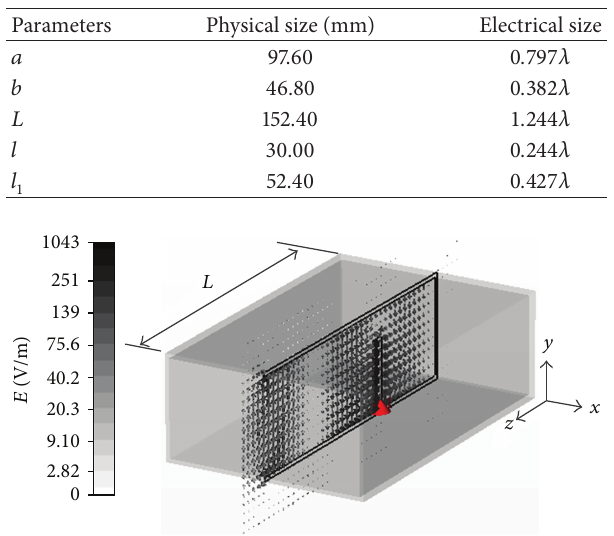
Table 1: Parameters of the antenna without the parasitic coupling apertures.